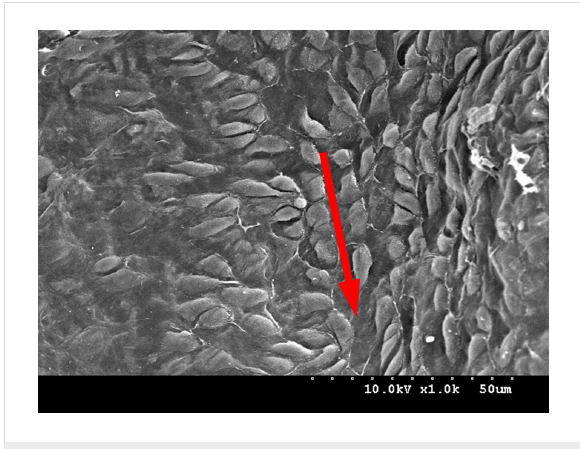
Figure 3: The direction of aligned cobblestones in the direction of blood flow.